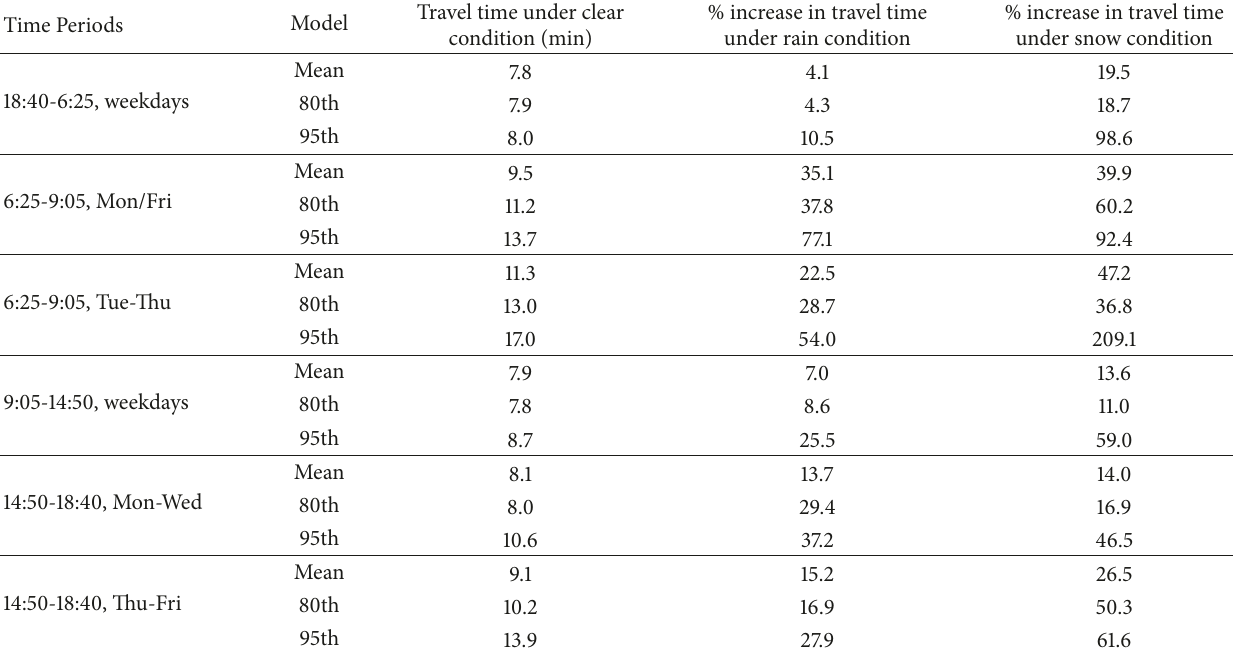
Table 2: Analysis results from regression